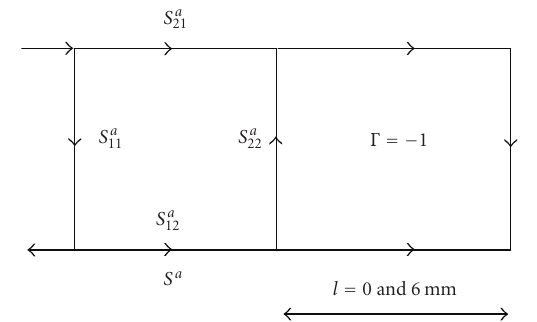
Figure 5: Reflection measurements for S a .